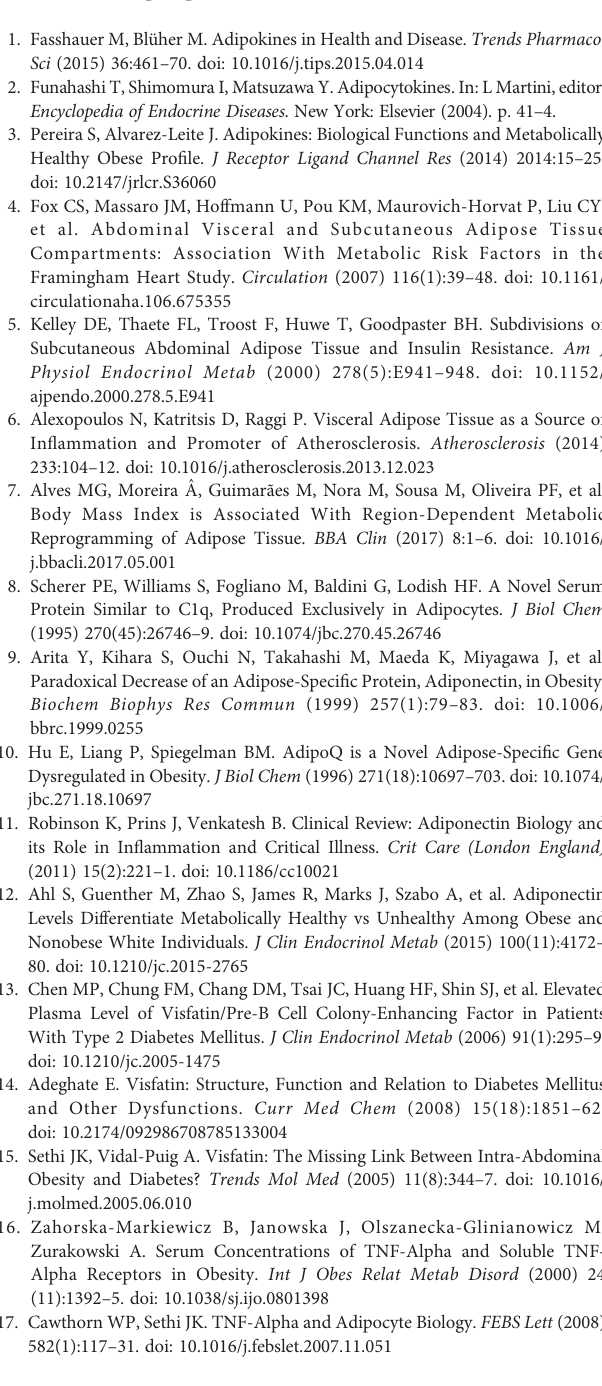
Supplementary Table 2 | (A) Abdominal compartments and the measured markers in the lean population (BMI < 25) (n = 40). AT, adipose tissue; sSAT, super fi cial subcutaneous adipose tissue; dSAT, deep subcutaneous adipose tissue, VAT, visceral adipose tissue. *p < 0.05 . (B) Abdominal compartments and